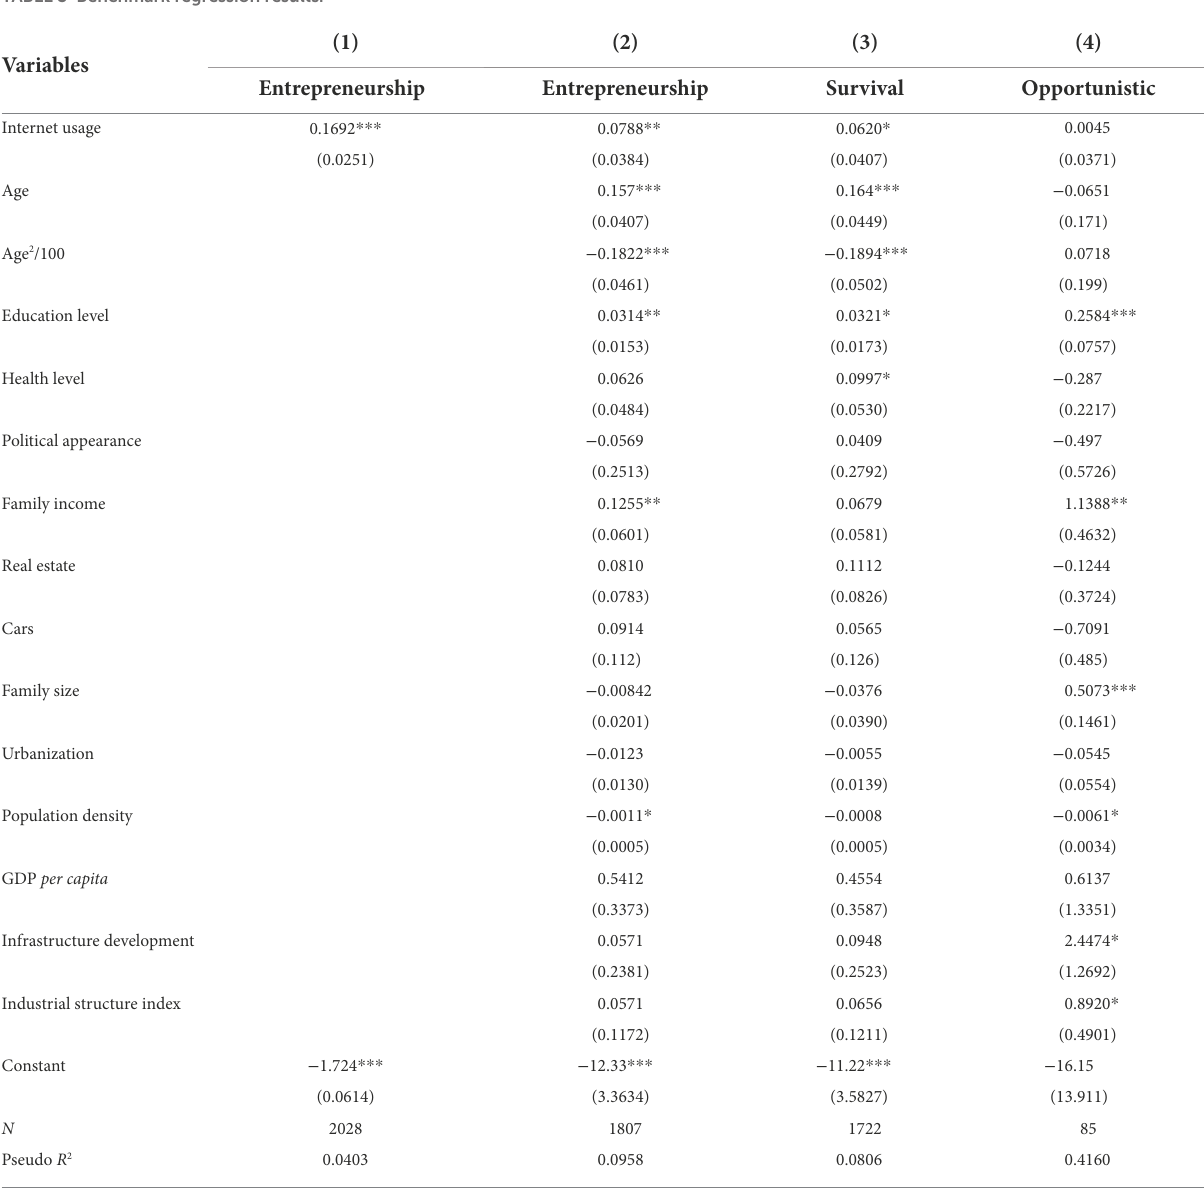
TABLE 3 Benchmark regression